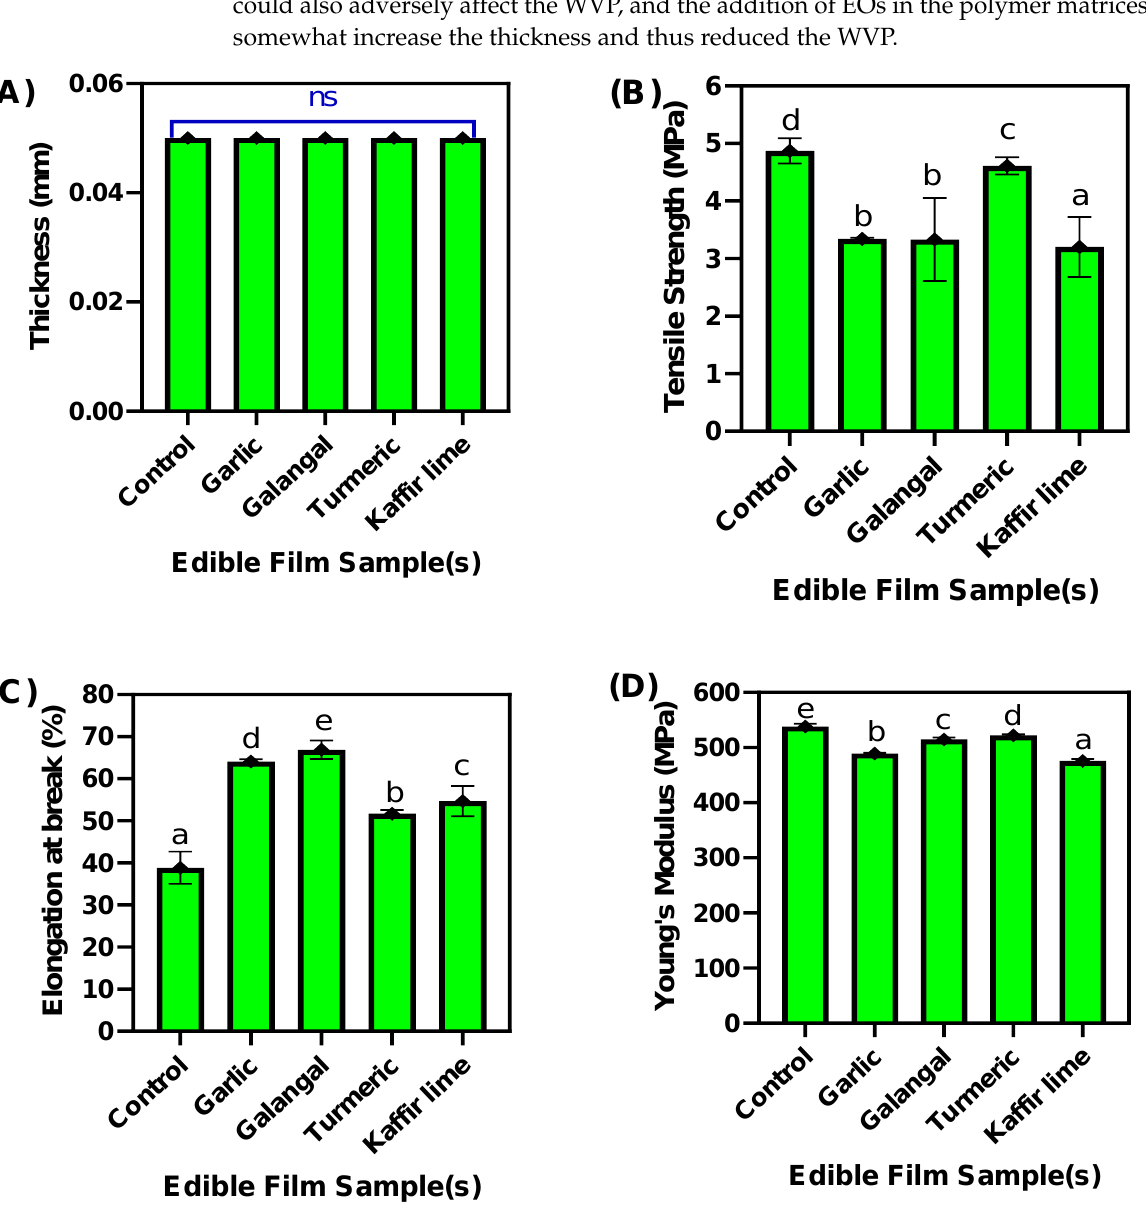
Figure 3. Thickness ( A ), tensile strength ( B ), elongation at break ( C ), and Young’s modulus ( D ) of chitosan–NGRS based edible film incorporated with and without EOs. Note: The different letters shown in the figure represents significant differences between means; ns represents non-signifi- cance.